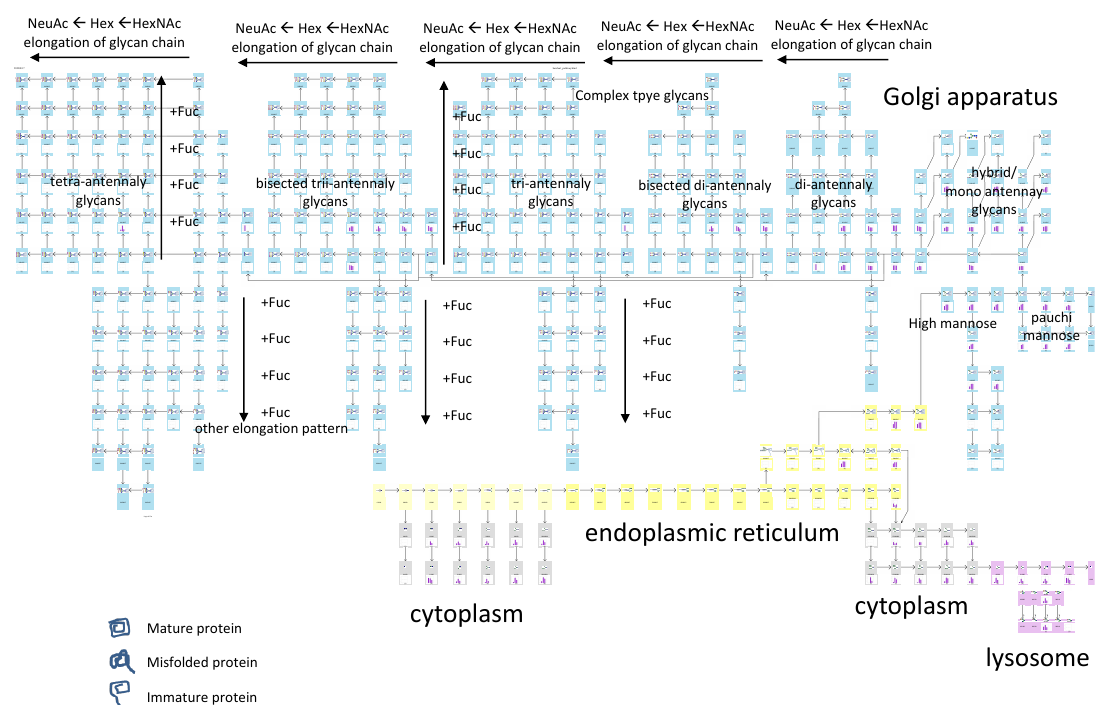
Figure 8. Overview of the structure for the biosynthetic pathway model for N -glycans and FNGs. Several pioneering studies reported various glycomic alterations in NPC involving various glycosphingolipids (GSL) (glucosylceramides (GlcCer), lactosylceramide (LacCer), GM2, GM3, and asiao-GM2) [28,29]. In addition, the disease-specific accumulation of various sialylated glycoconjugates within endocytic compartments of Npc1 -null and Npc2 -deficient fibroblasts is caused by impaired recycling as opposed to altered fusion of vesicles. The treatment of either Npc1 -null or Npc2 -deficient cells with cyclodextrin was e ff ective in reducing cholesterol storage, as well as the endocytic accumulation of sialylated glycoconjugates [30], although structure-intensive analysis was not performed in this study. Our previous study using Npc1 KO CHO cells identified a number of glycomic alterations, including an increased expression of LacCer, GM1, GM2, GD1, various neolacto-series glycosphingolipids, and sialyl-T ( O -glycan), as well as various N -glycans, which were typically both fucosylated and sialylated. We also observed significant increases in the total amounts of free N -glycans (FNGs), especially in the unique complex- and hybrid-type FNGs. The treatment of Npc1 KO CHO cells with 2-hydroxypropyl- β -cyclodextrin (HPBCD) did not a ff ect the glycomic alterations observed in the GSL-, N -, and O -glycans of Npc1 KO CHO cells. However, HPBCD treatment corrected the glycomic alterations observed in FNGs to levels observed in wild-type cells